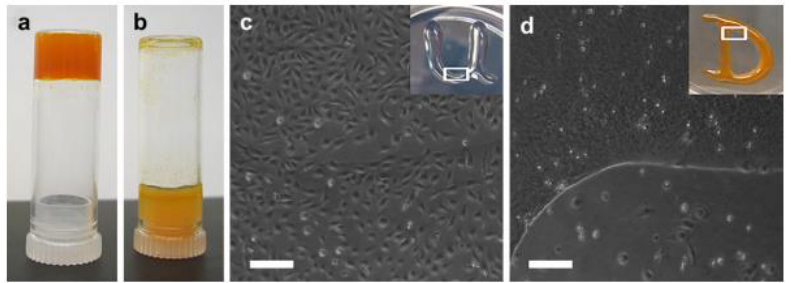
Figure 5. ( a , b ) Characterization of MAX8 hydrogels loaded with curcumin. ( c , d ) DAOY cells seeded with MAX8 hydrogels with or without curcumin. Reproduced with permission from [103]. Copyright 2011, Elsevier .